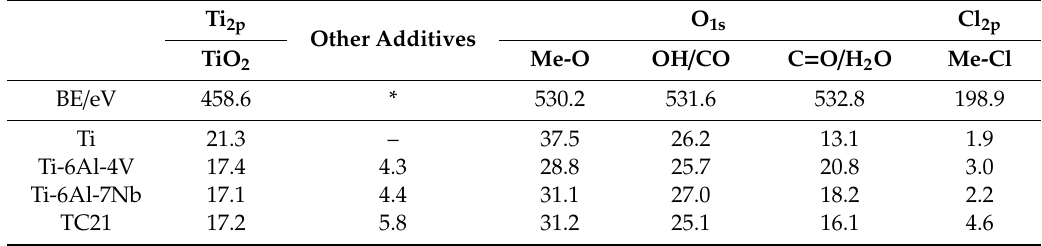
Table 7. XPS deconvolution results carried out in Ti 2p , Cl 2p and O 1s energy range after seven days of exposure to 0.9% NaCl solution at 37 ◦ C (in at.%).